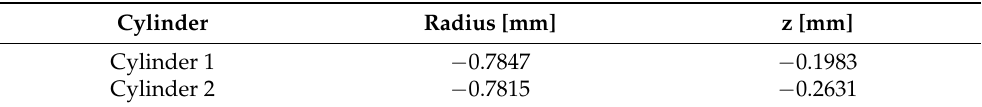
Table 4. Deviations of the cylinder measurements between touch probe and laser object detection with laser scanner.